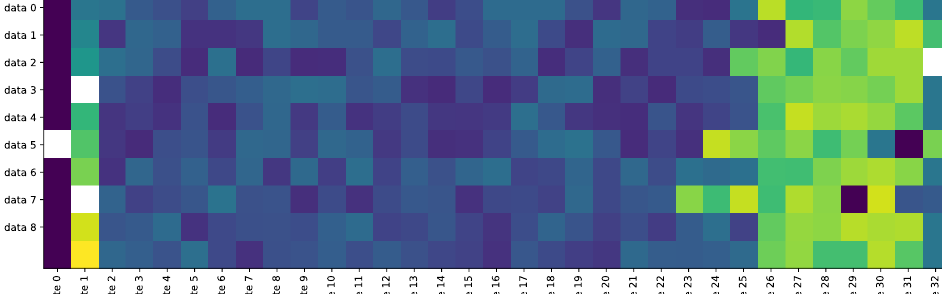
Figure 2. High-level acquisition drivers. Our architecture connects hardware features with the OpenBCI SDK to access all configuration modes, resulting in a cross-platform driver with low-level features (represented by blue boxes). External systems will utilize these features to deploy high-level, context-specific features. Raw block of binary data with inconsistent bytes and missing ones.